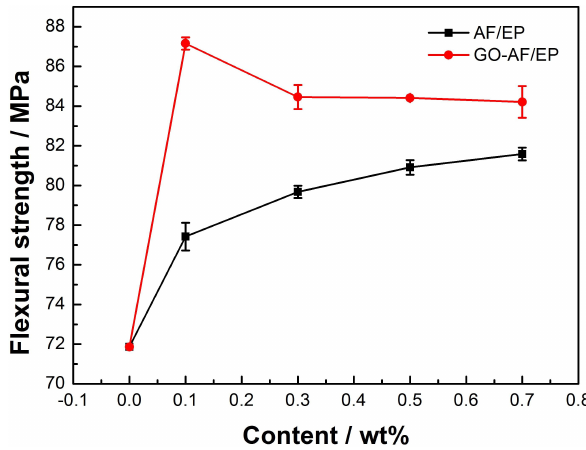
Figure 10: Flexural strength of epoxy resin and GO-AFs/epoxy com- posites with different mass fractions of GO-AFs